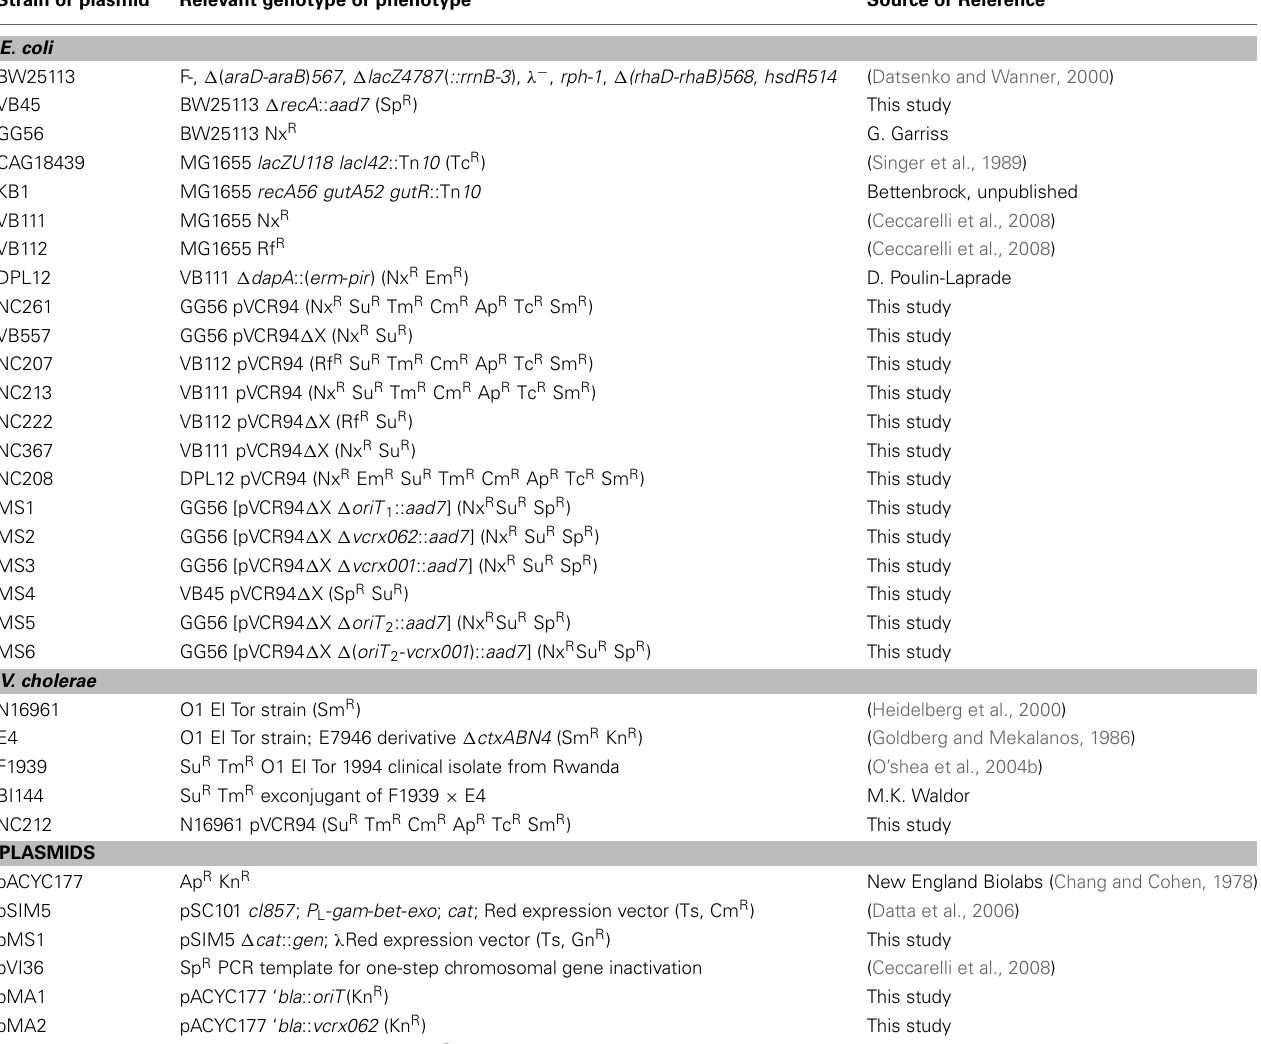
Table 1 | List of strains and plasmids used in this study. Strain or